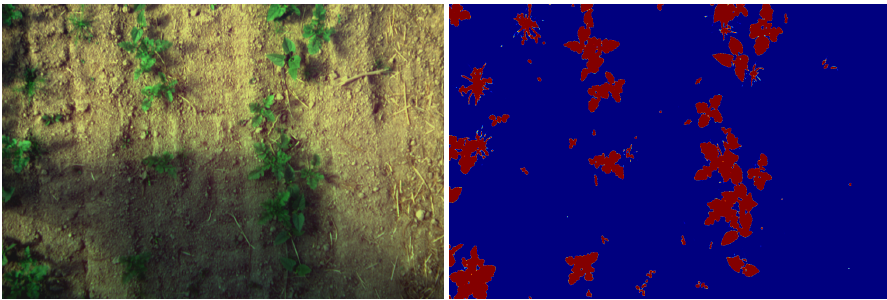
Figure 13. Correct vegetation/soil discrimination despite shadows. Some problem occurs when there are abrupt transitions between shadowed and light areas of an image as shown in Figure